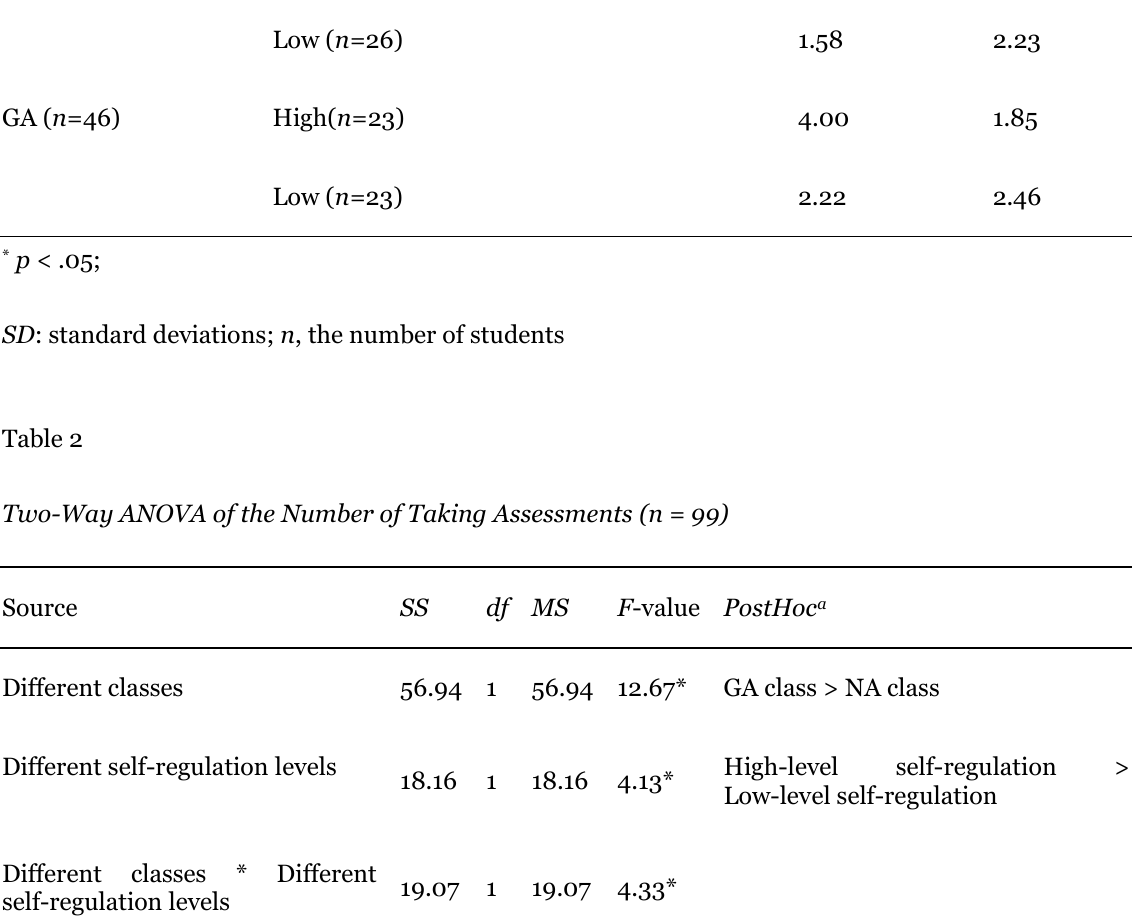
System (or Class)